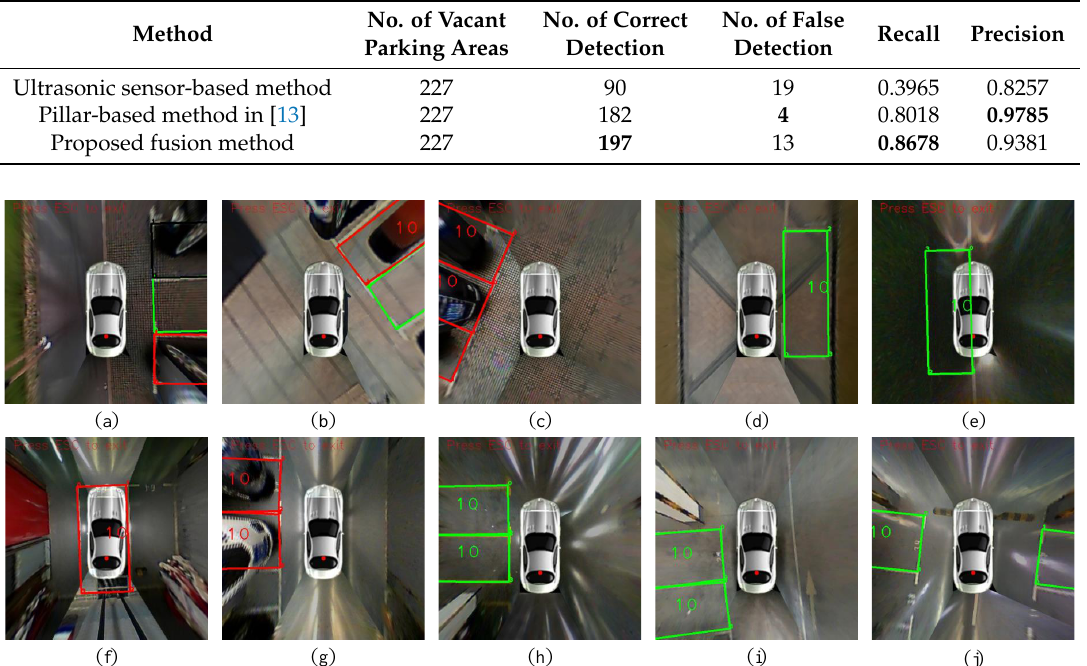
Figure 11. Parking area detecting results. The green box means the parking area is vacant and the red one means unparkable. ( a – e ) are the ground detecting results. The sceneries includes different ground materials and light conditions. ( e ) is the nighttime detecting results. ( f – j ) are the underground detecting results containing both white and yellow parking lines. The ground reflection and poor light condition are the biggest challenges for